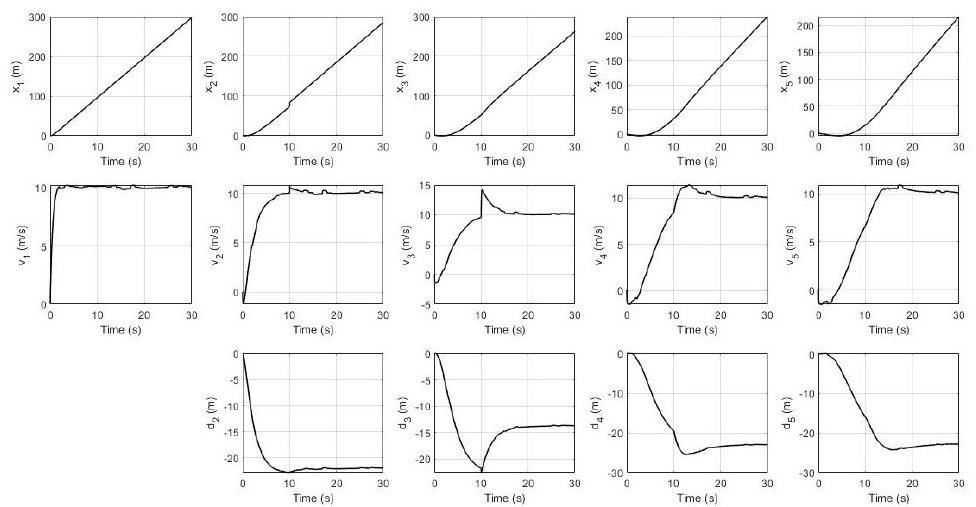
Figure 7. System’s response with sensor S1 fault in the 2nd robot.